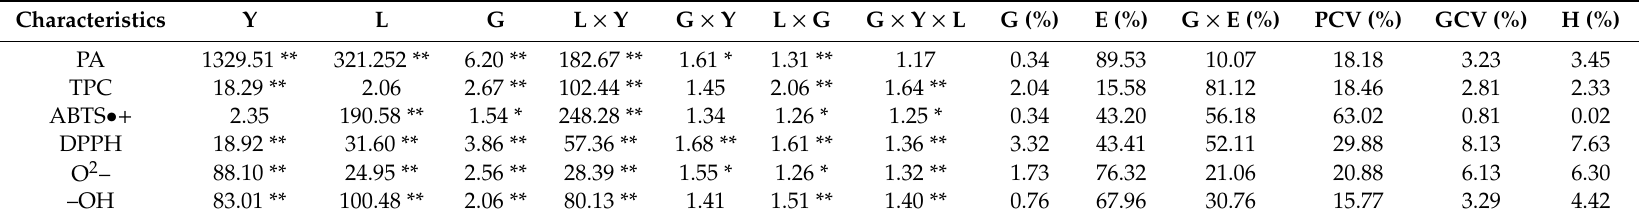
Table 4. ANOVA of genotype, crop years, and growing locations on bioactive compounds contents and antioxidant capacities of wheat.